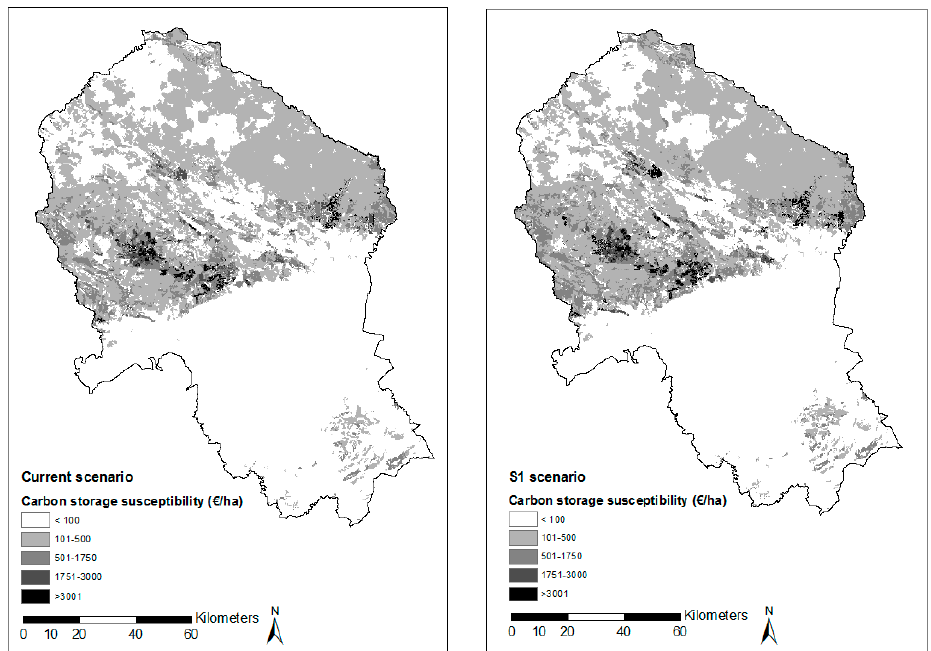
Figure 4. Economic susceptibility of carbon storage under baseline period and S1 scenario for Córdoba province.